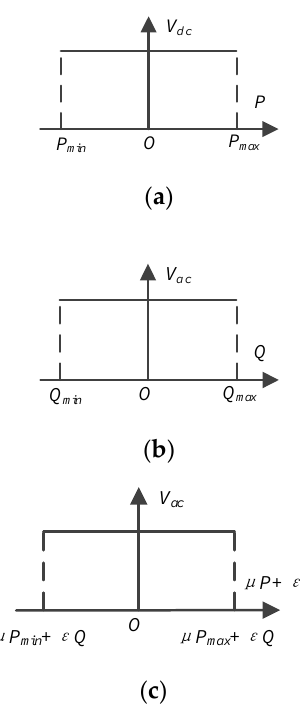
Figure 4. Inner loop control strategy of soft open point.